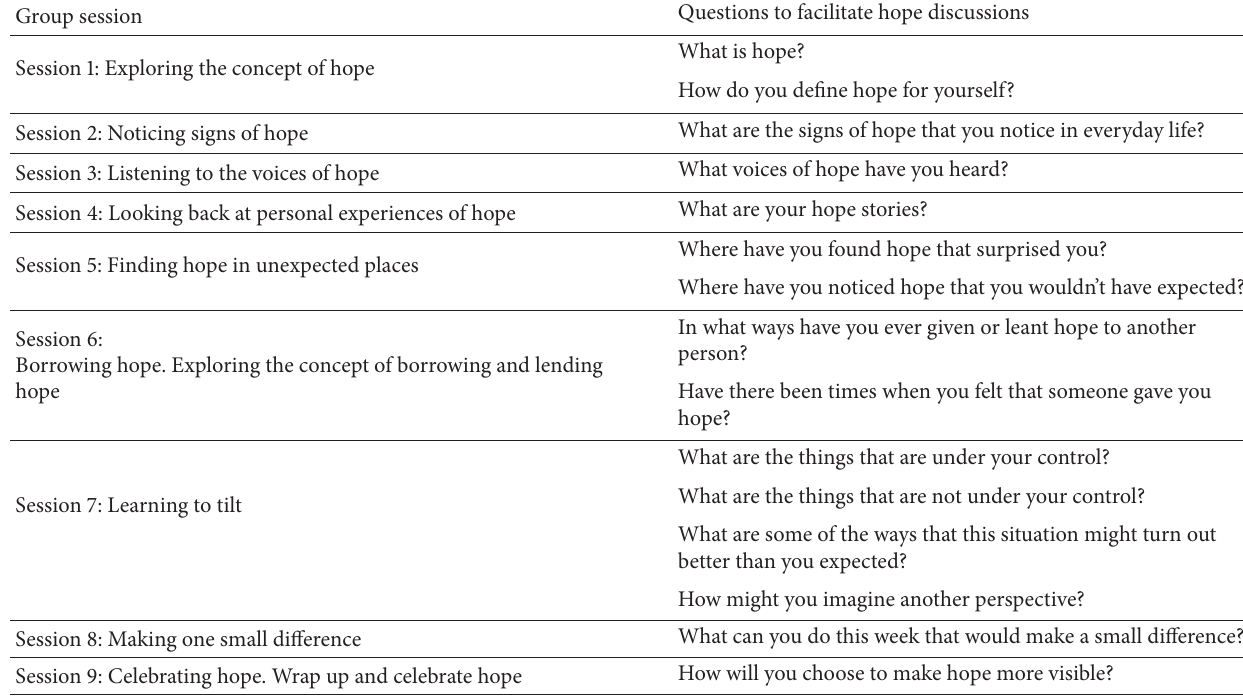
Table 2: Focusing questions for group